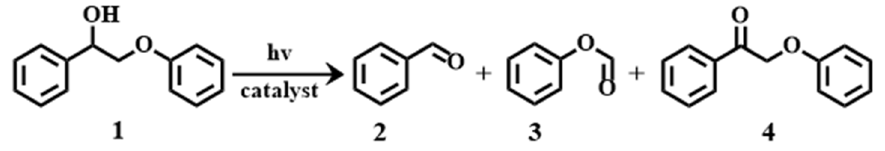
Figure 8. Schematic diagram of photocatalytic conversion of ML. (1–4 represented 2-phenoxy-1- phenylethanol, benzaldehyde, phenyl formate and 2-phenoxyacetophenone, representatively)